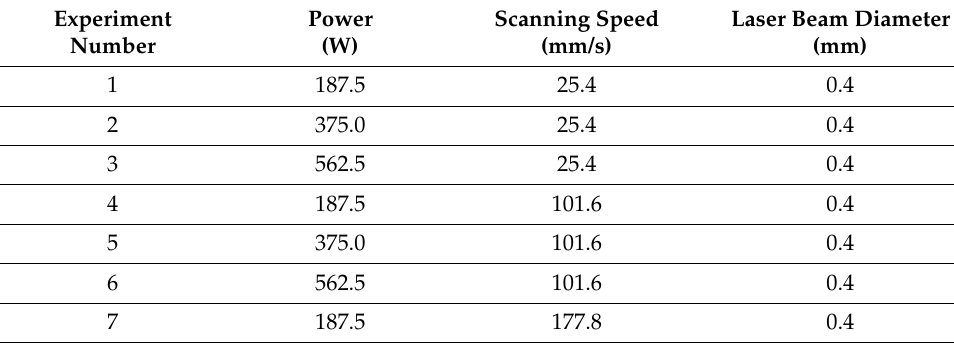
Table A1. Laser Scanning Process